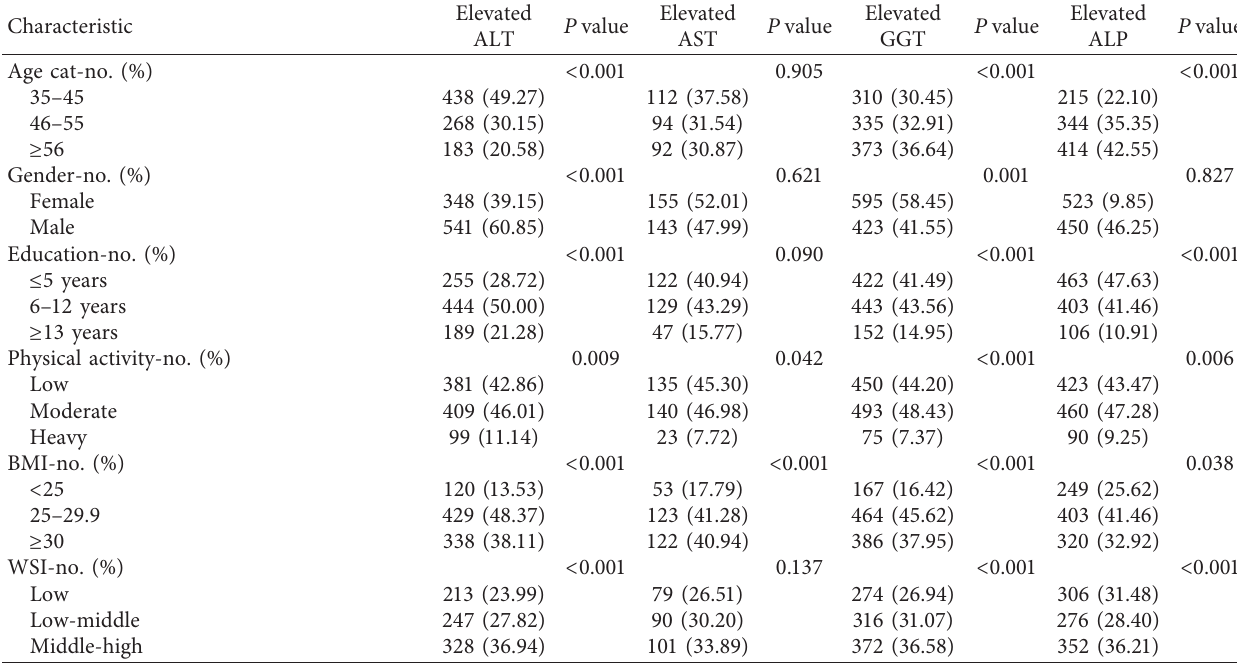
Table 2: The associations of the liver enzymes with demographic and selected medical and laboratory characteristics in the study